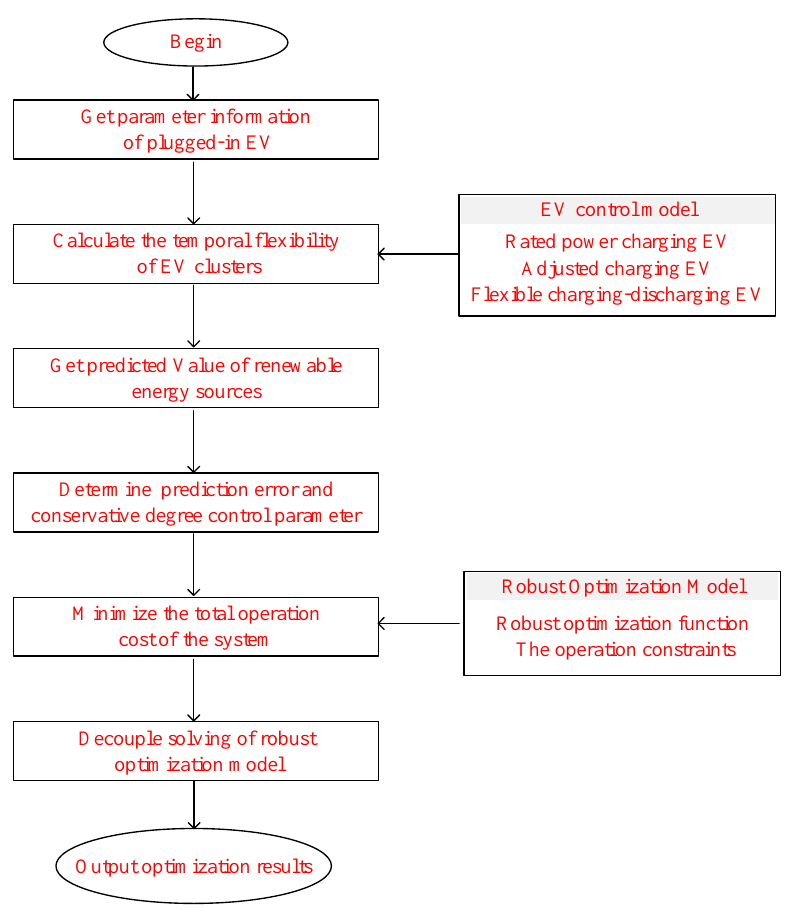
Figure 3. Flow chart of the optimization process.